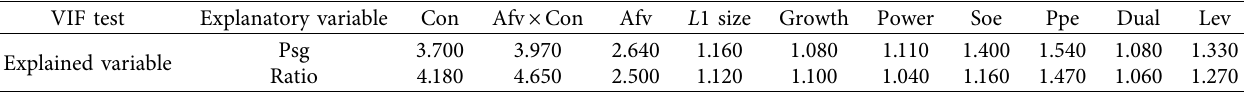
Table 3: Variance inflation factor (VIF)